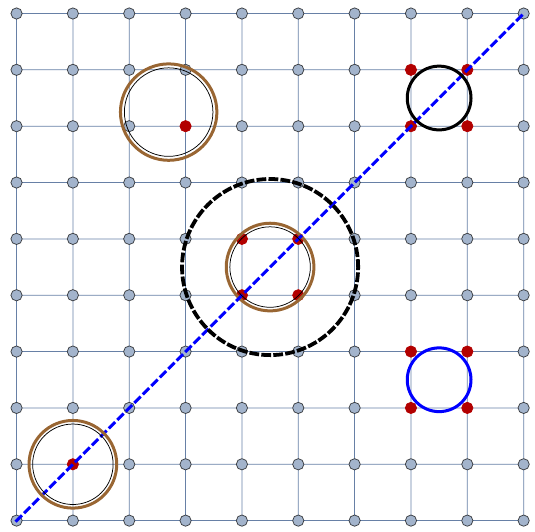
Figure 3 . Operator spectrum of chiral Monster CFT tensored with its antichiral avatar on ( h 0 ; (cid:22) h 0 ) plane: each vertex in the lattice represents the presence of operators. One can always circumscribe a square of unit length by a circle of radius 1 p . Thus any circle centered at ( h; (cid:22) h ) and of radius 2 1 p + (cid:15) g with (cid:15) g > 0 would contain at least an operator. This is consistent with our result that 2 asymptotically any circle of radius (cid:13)r p + (cid:15) g with (cid:13) (cid:21) 1 will contain at least one operator where (cid:13) 2 is de(cid:12)ned as the fourth root of asymptotic ratio of max( h; (cid:22) h ) and min( h; (cid:22) h ). We show r = 4